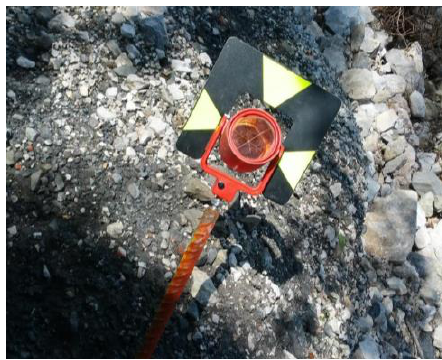
Figure 2. Tachymetric control point – reflector mount mounted onto steel rods and stabilised into landslide mass